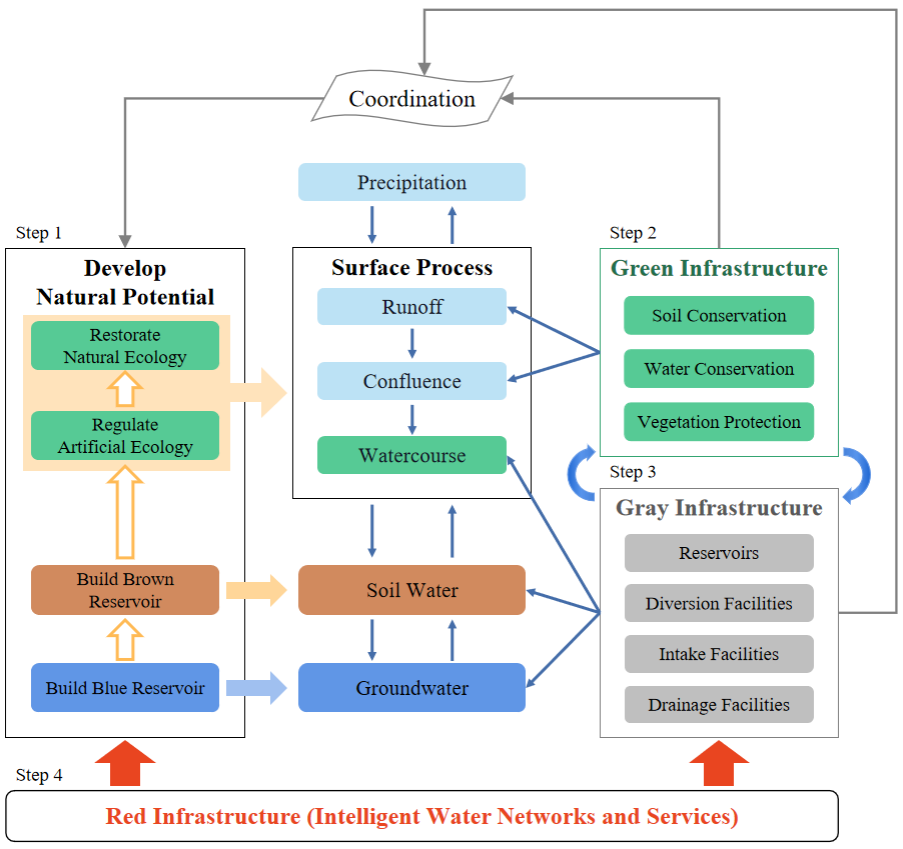
Figure 2. General idea of the Sponge-Smart River Basins (Yan et al.